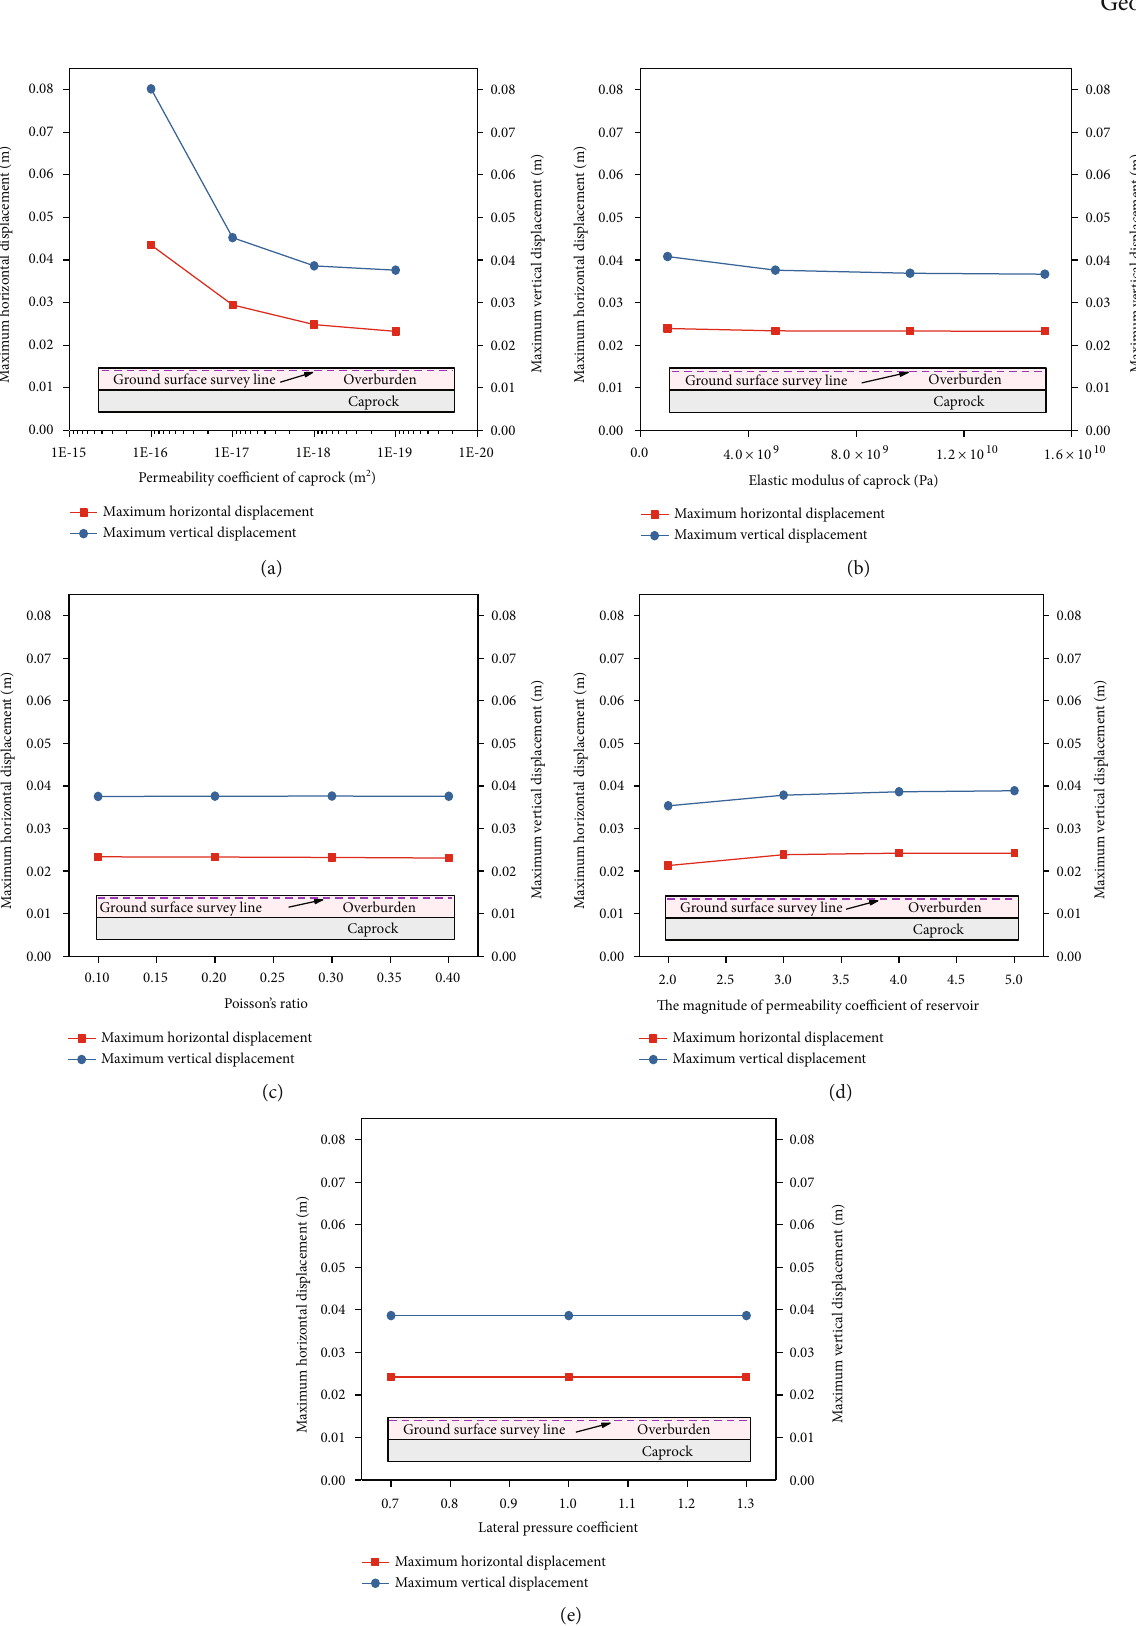
Figure 19: The variation curve of maximum surface deformation with di ff erent input parameters. (a) Permeability coe ffi cient of caprock. (b) Elastic modulus of caprock. (c) Poisson ’ s ratio of caprock. (d) Di ff erent permeability of reservoir. (e) Lateral pressure coe ffi